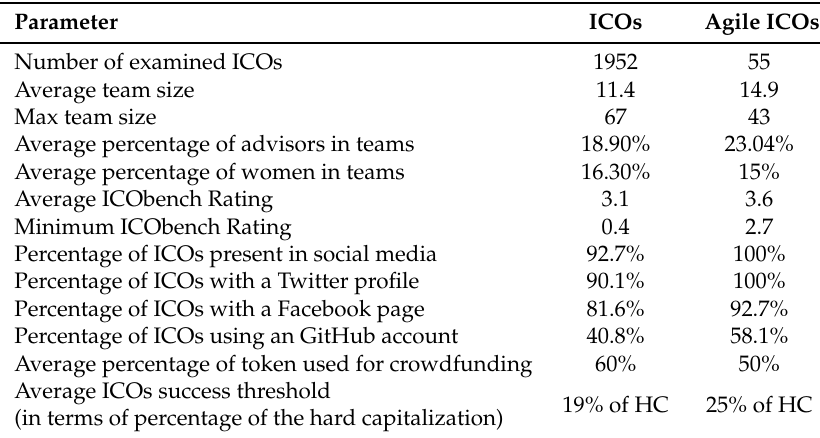
Table 6. Comparison between ICOs and Agile